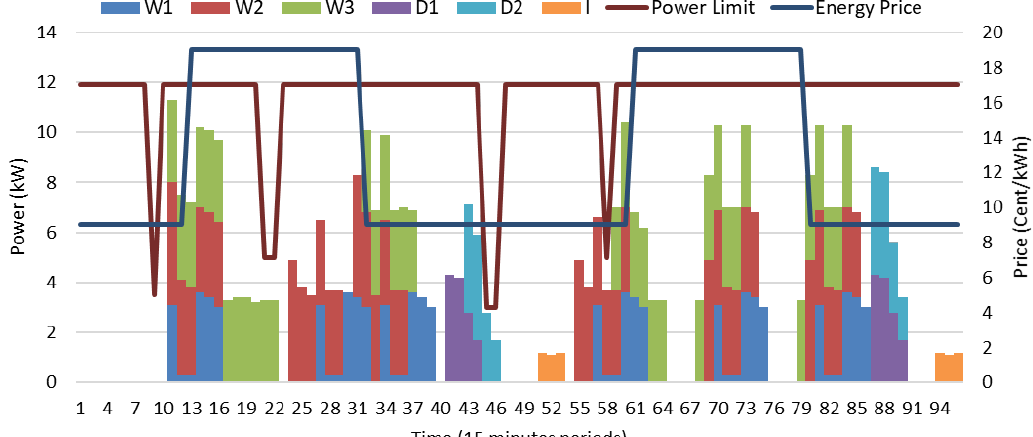
Figure 6. Power consumption of devices in scenario C (based on double-tariff pricing and power consumption limit).